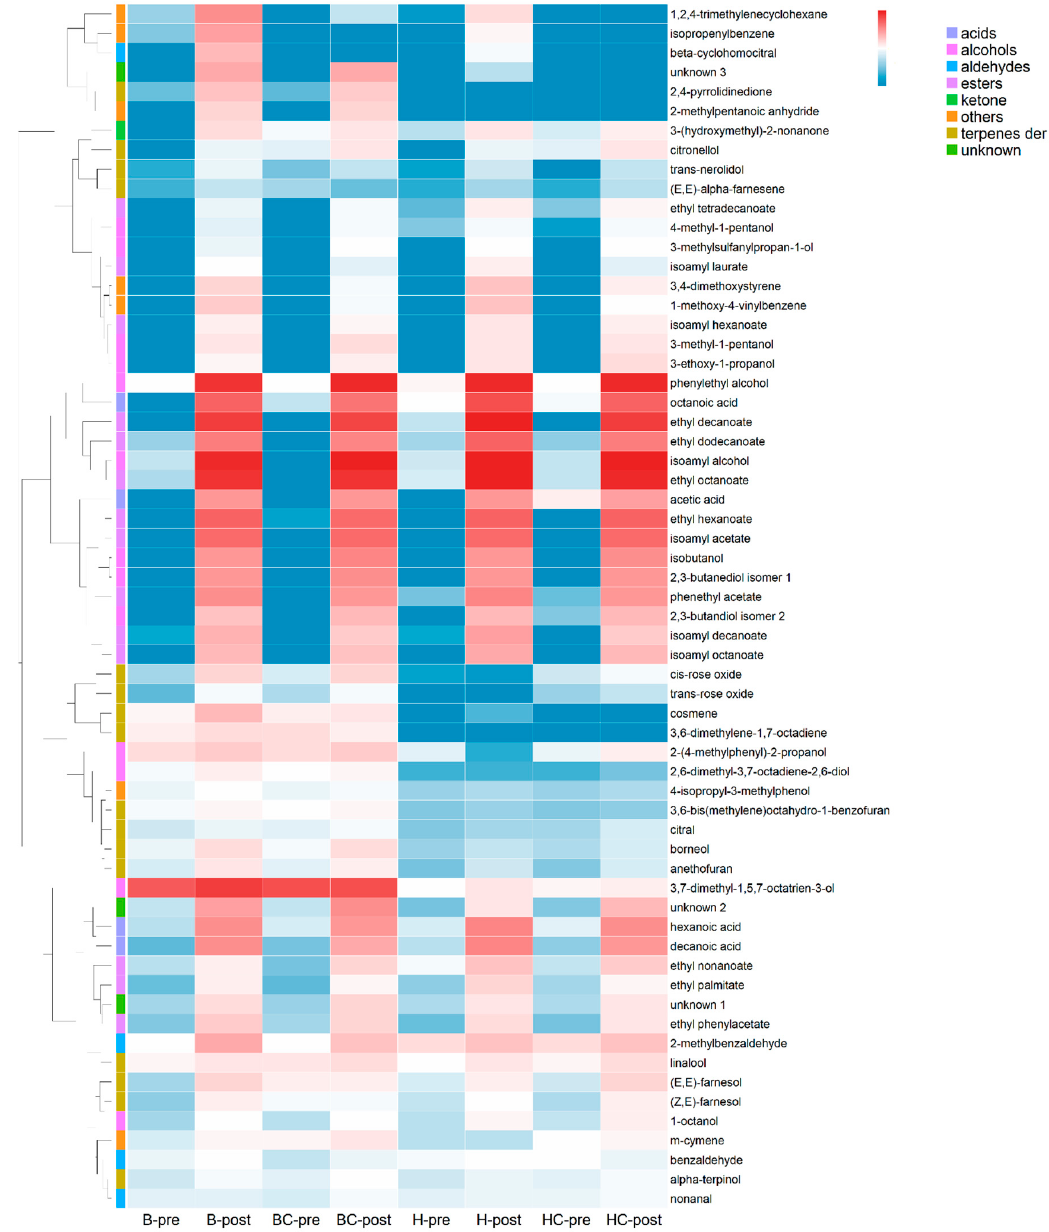
Figure 2. Heatmap and one-dimensional hierarchical dendrogram of the volatile compounds found in the investigated samples. Heatmap represents a log10 transformed data (average of three replicates). The heatmap color represents the magnitude of each compound. Dark red color indicates the higher magnitude, and then the magnitude gradually decreases to light red, white, light blue, up to dark blue (one order each), with the latter, indicating the lower magnitude. The magnitude represents transformed data (log10 of the ratio) to fit them in the same range. On the left: the colored sidebar indicates the class of metabolites. Sample legend: B = blossom honey, BC = blossom honey with blackcurrant, H = honeydew honey, HC = honeydew honey with blackcurrant, pre = pre-fermentation, and post = post-fermentation.